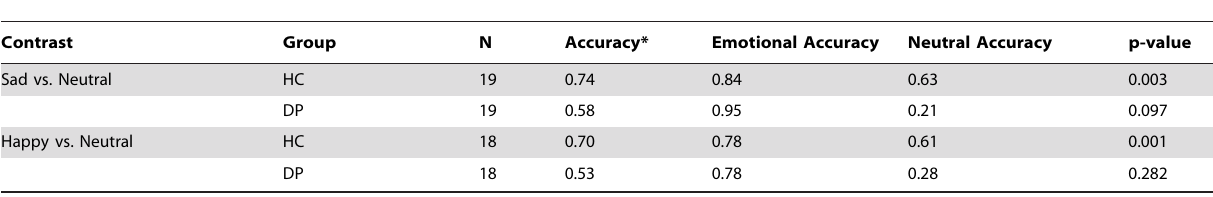
Table 2. Within-group decoding accuracy in Healthy Controls (HC) and Depressed Patients (DP).